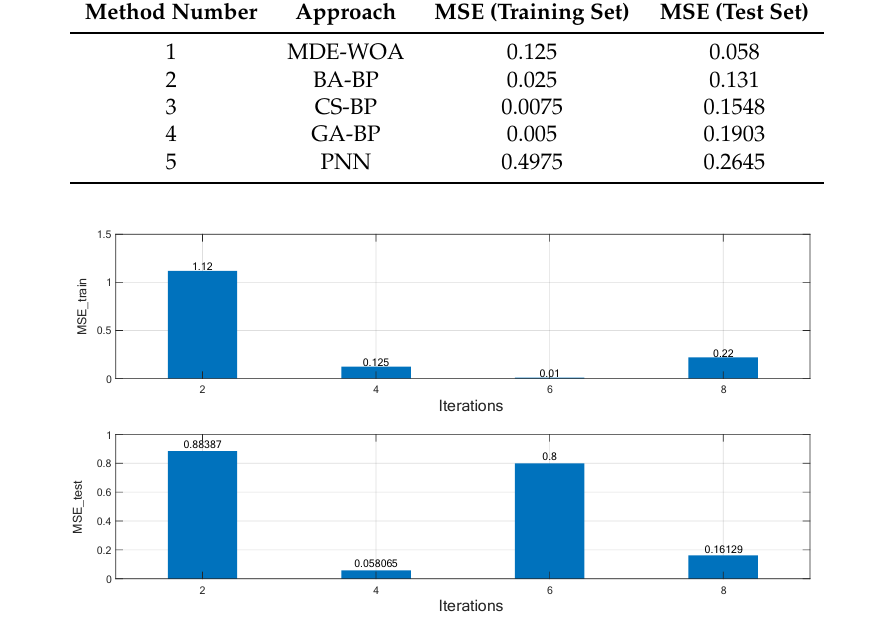
Table 4. A comparison mean square error (MSE) error of different algorithms.